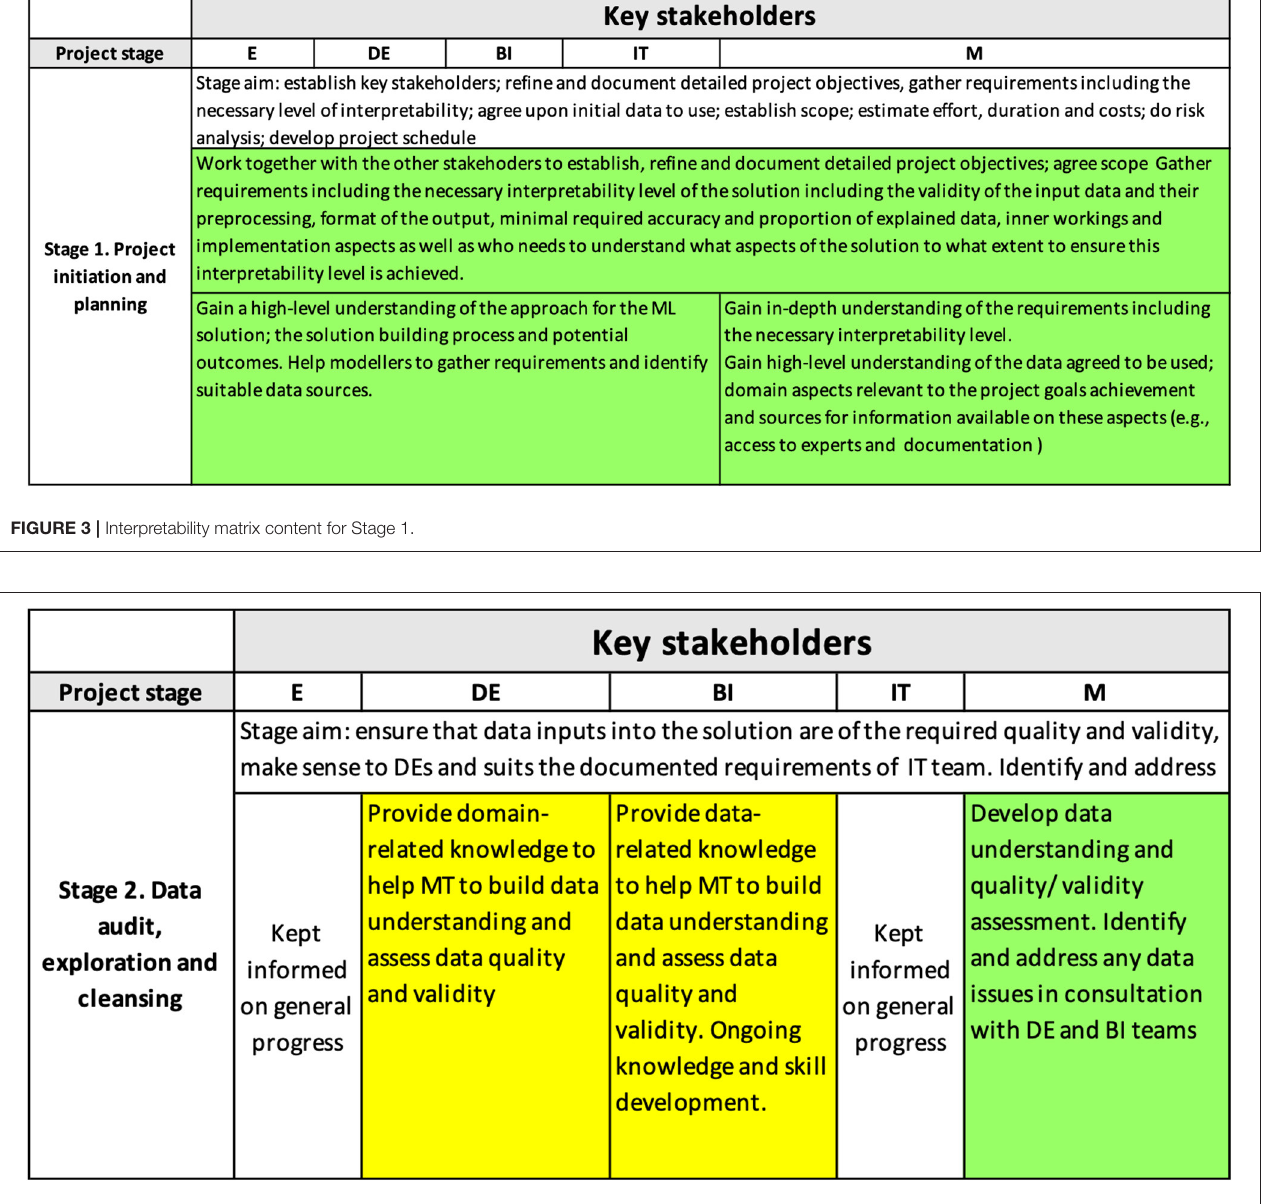
FIGURE 4 | Interpretability matrix content for Stage